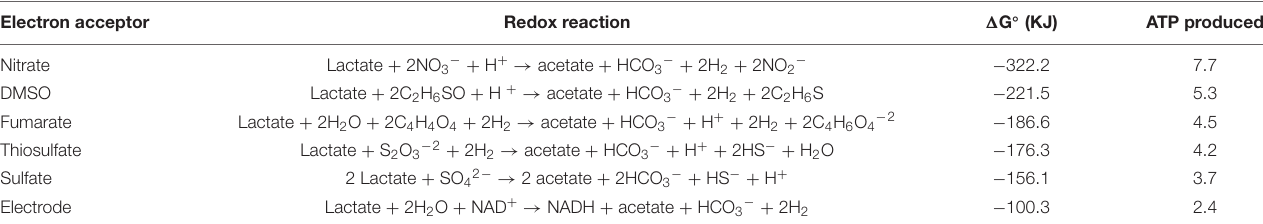
TABLE 2 | Energy available for growth and amount of ATP that can be produced upon coupling lactate oxidation to utilization of the indicated electron acceptors. Electron acceptor Redox